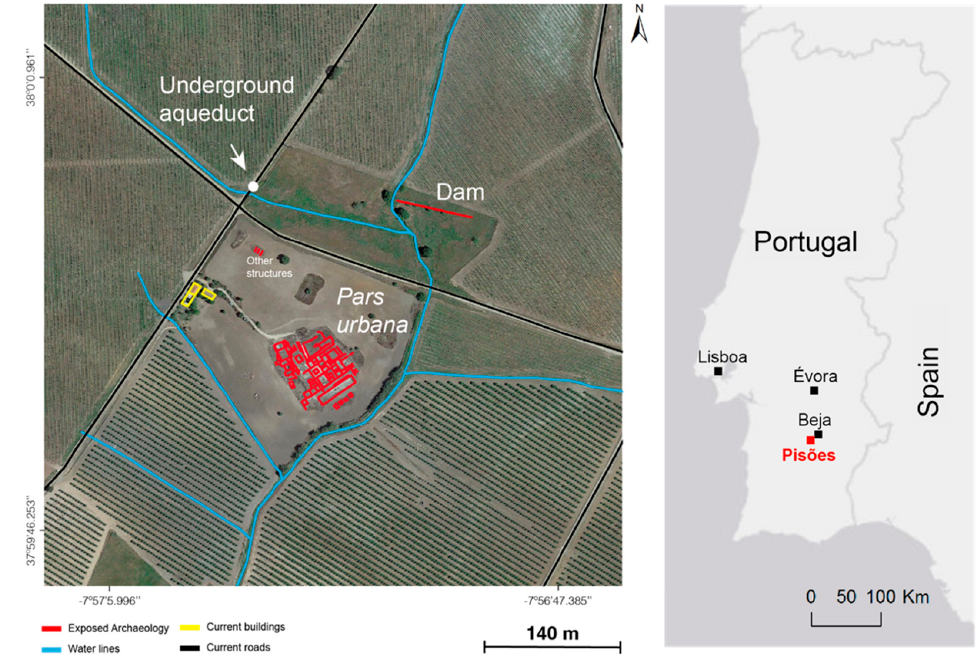
Figure 1. Location of the Roman villa of Pisões and general overview of the site.